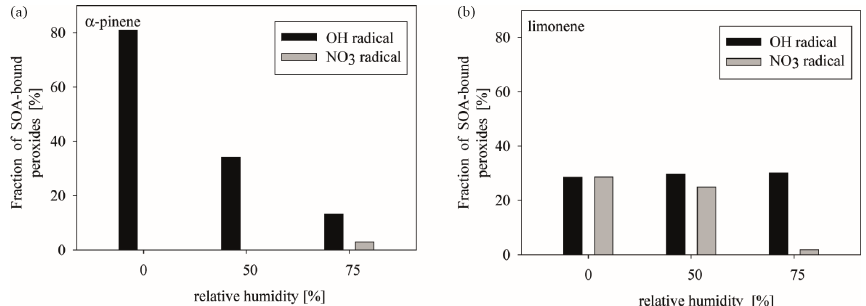
Figure 5. Fraction of SOA-bound peroxides from α -pinene (a) and limonene (b) oxidation with OH radicals (black) and NO 3 radicals (grey). Quantification was done following the method described by Mutzel et al. (2013) assuming a molar mass of 300gmol − 1 (Docherty et al.,